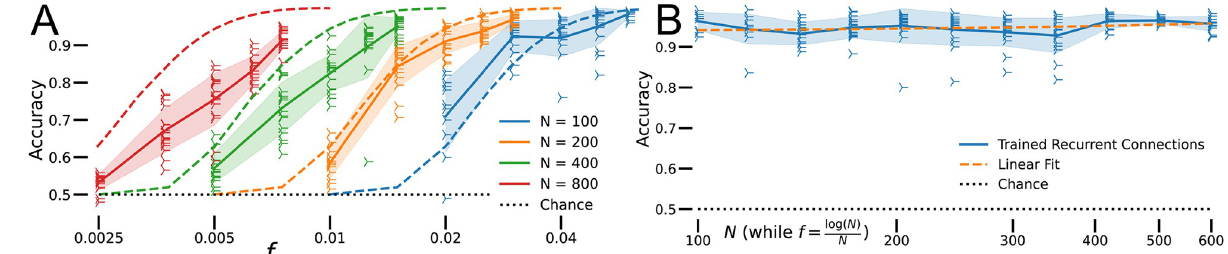
Fig 3. Extreme sparsity. A: Performance of sparse RNNs at extreme sparsity levels as a function of model size (scatter points; solid lines are averages and shaded areas are standard deviations). Predictions based on empirical analysis of random directed graphs (dashed lines). α = 0.5, # epochs = 500, n = 16. B: Performance of nearly strongly connected sparse RNNs at the extreme sparsity level f = log( N )/ N for various networks sizes—the size of the strongly connected sub-network is at least 0.95 N for each simulation shown (blue scatter points; blue solid lines are averages and blue shaded areas are standard deviations). Linear fit of all the points is shown as orange dashed line. α = 0.5, # epochs = 1000, n = 16.